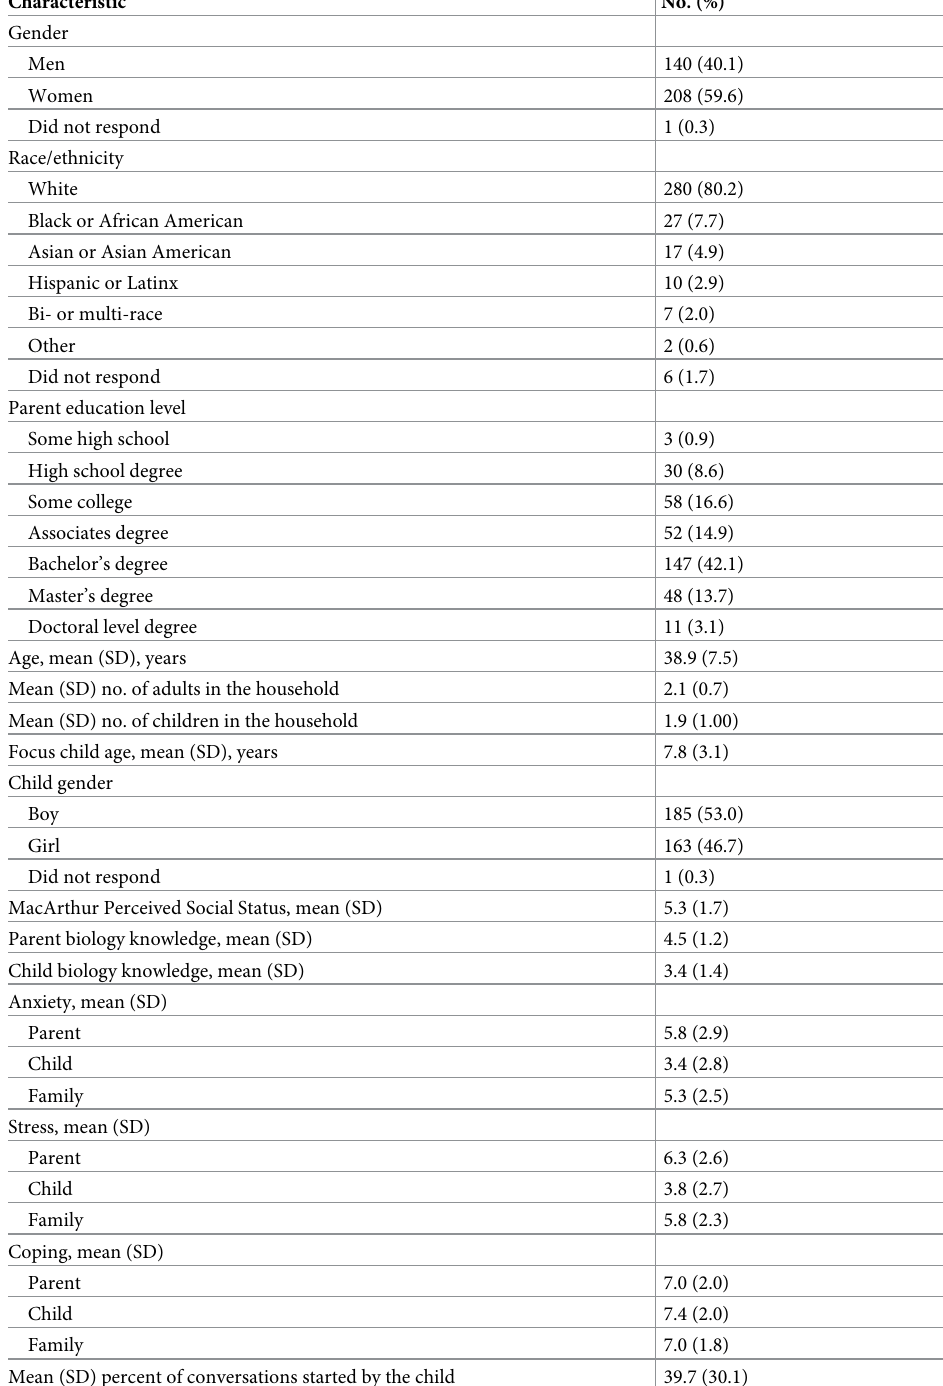
Table 1. Demographic information of